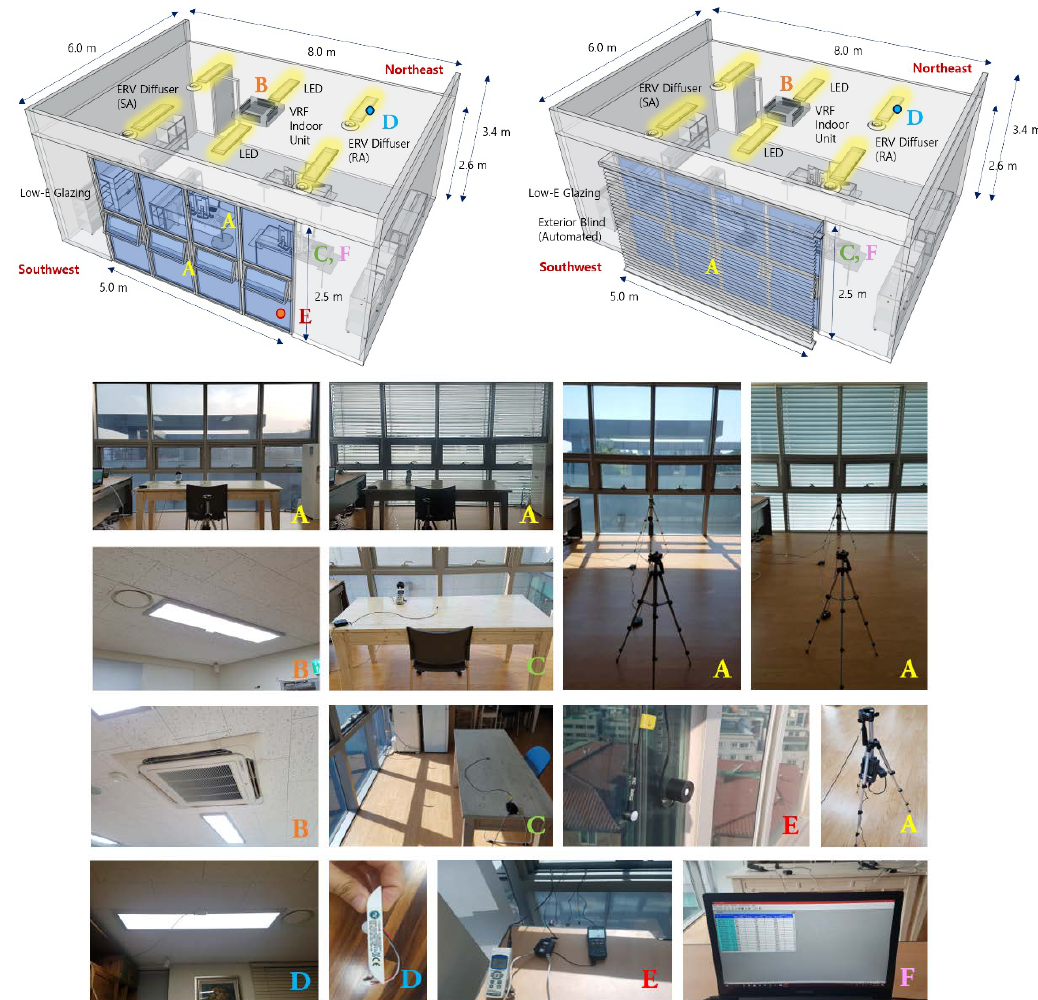
Figure 5. Full-scale mock-up overview and site images.